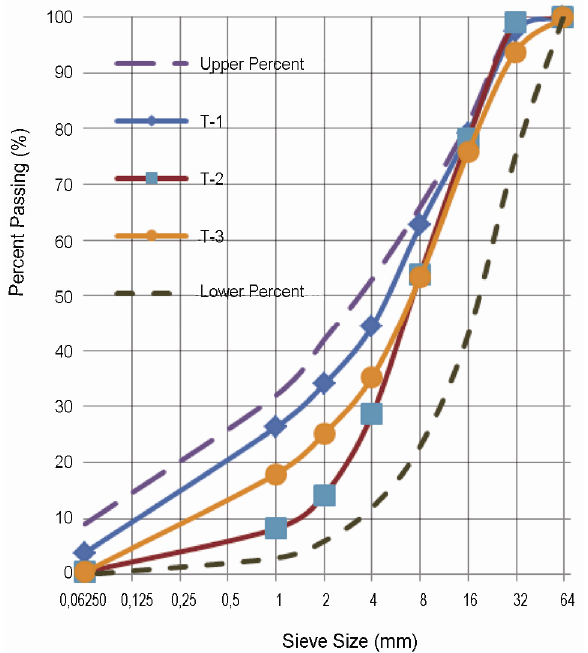
Fig. 2. Grading curves for the tested aggregates